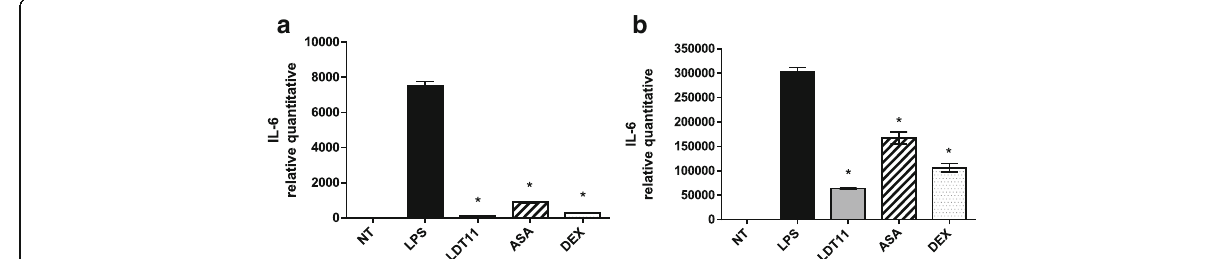
Fig. 10 Determination of the relative amount of IL-6 gene transcripts in RAW 264.7 cell line for the evaluation of inflammatory response at 6 ( a ) and 24 h ( b ) post-stimulus. NT- untreated cells; LPS - LPS-stimulated cells; LDT11 - cells treated with LDT11 and then with LPS; AAS - cells treated with commercial acetylsalicylic acid and then with LPS; DEX - cells treated with the commercial anti-inflammatory Dexamethasone and then with LPS. All data are from at least three independente experiments, * p < 0.05, statistically different compared with cells